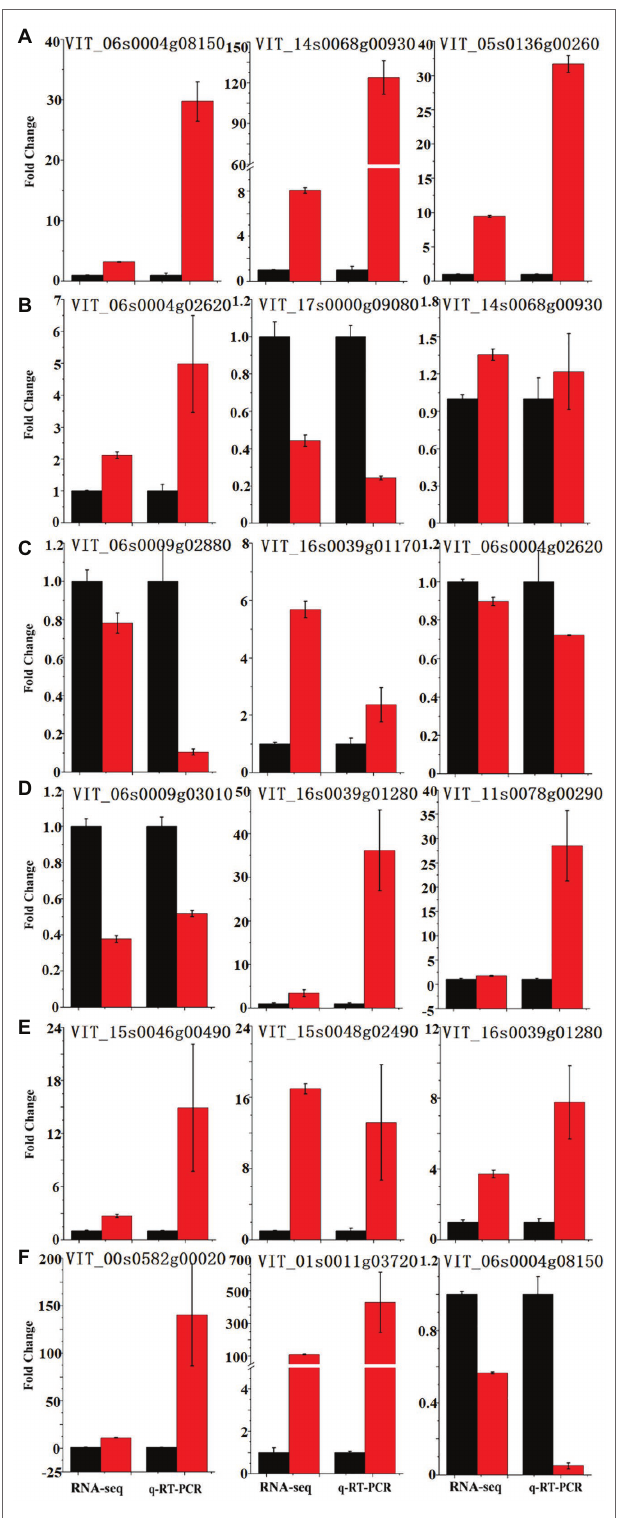
FIGURE 4 | Real-time quantitative reverse transcription (qRT)-PCR validation of the differentially expressed genes between ‘Summer Black’ (black bar chart) and its bud sport ‘Nantaihutezao’ (red bar chart). (A) S5; (B) S6; (C) S7; (D) S8; (E) S9; and (F)